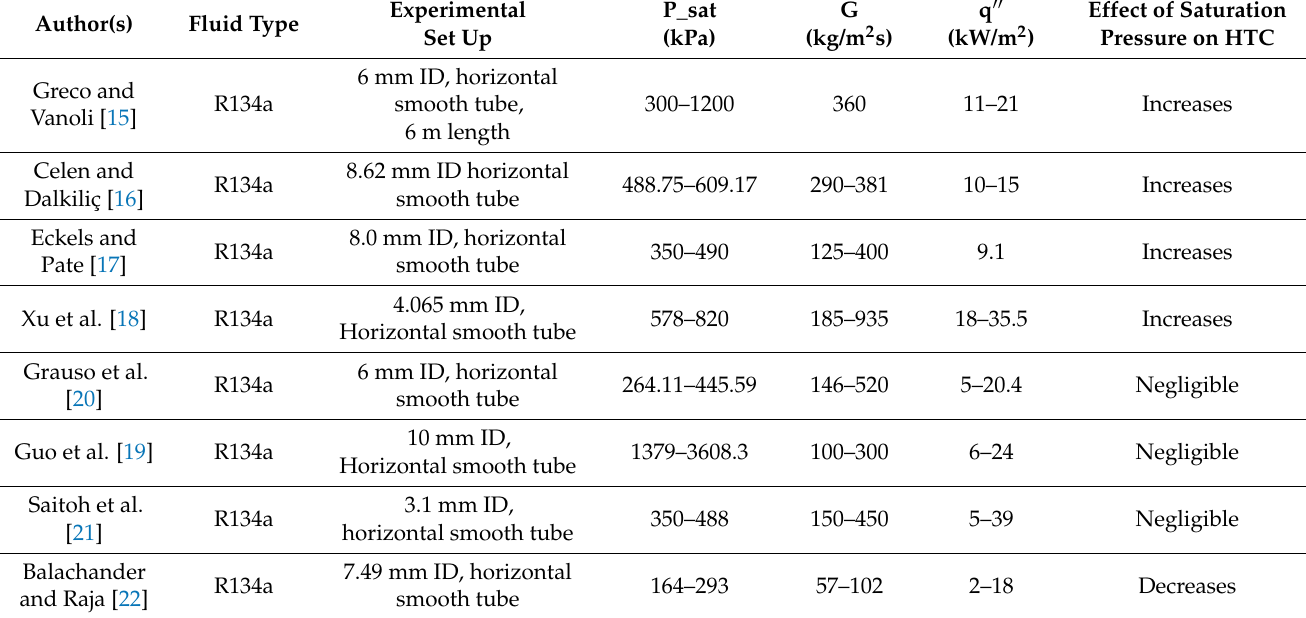
Table 1. Summary of experimental studies on flow boiling for R134a in horizontal smooth